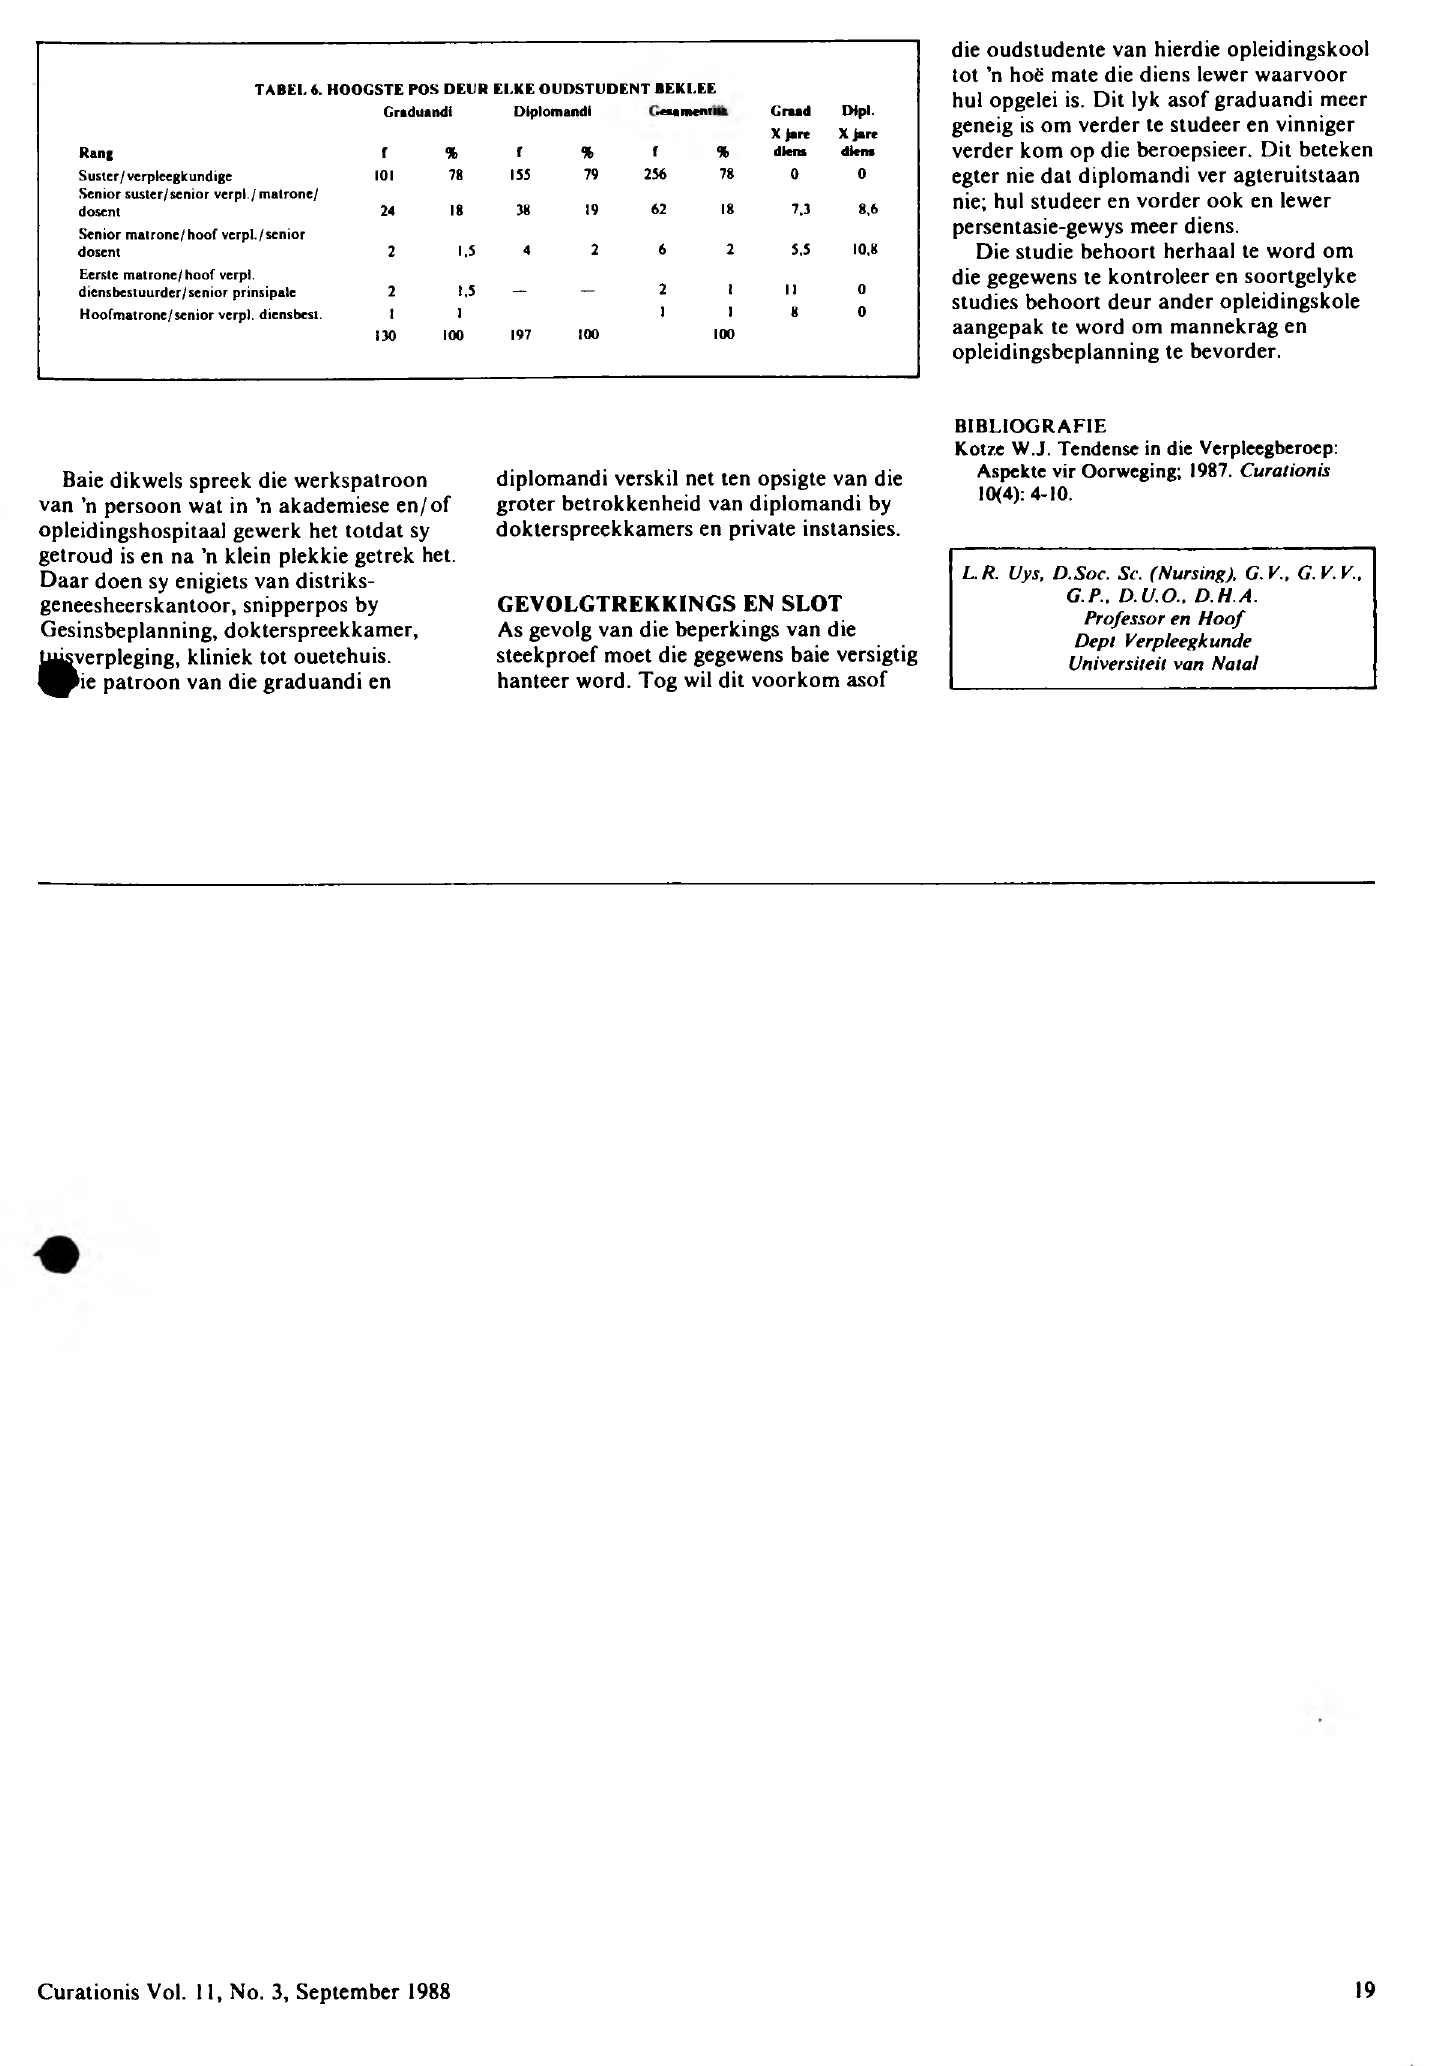
TABKL 6. HOOGSTE POS DEUR ELKE OUDSTUDENT BEKLEE